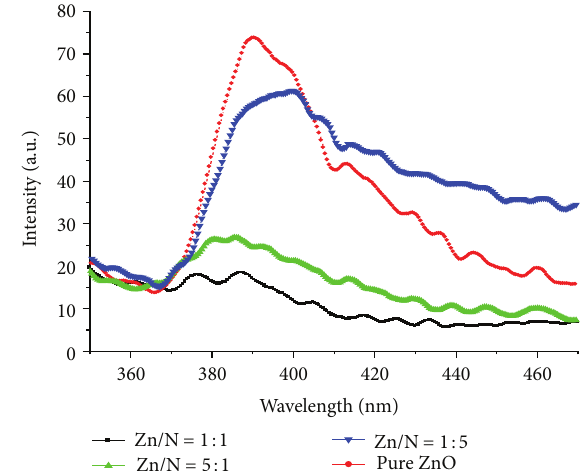
Figure 3: Photoluminescence spectra of samples with different Zn/N molar ratios calcined at 400 ∘